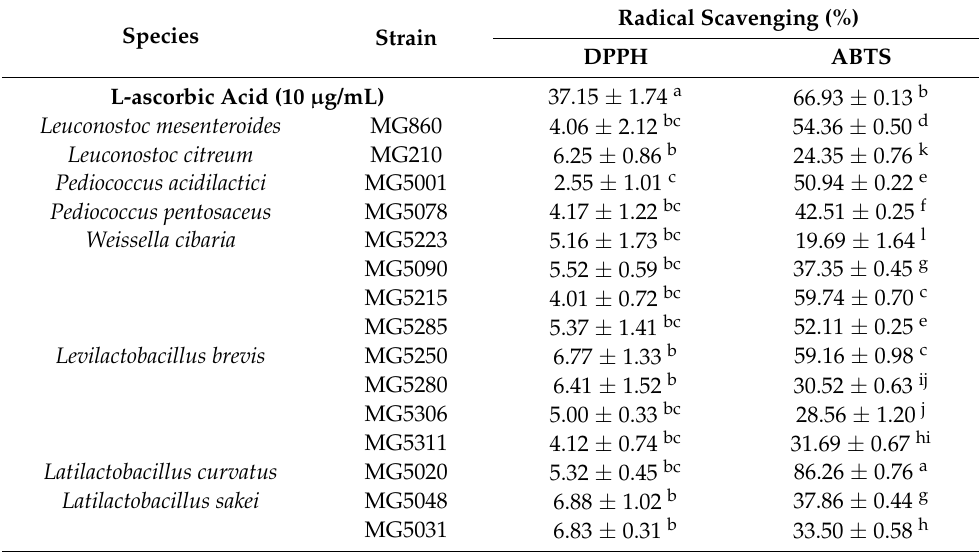
Table 1. Antioxidant activity of isolated lactic acid bacteria.